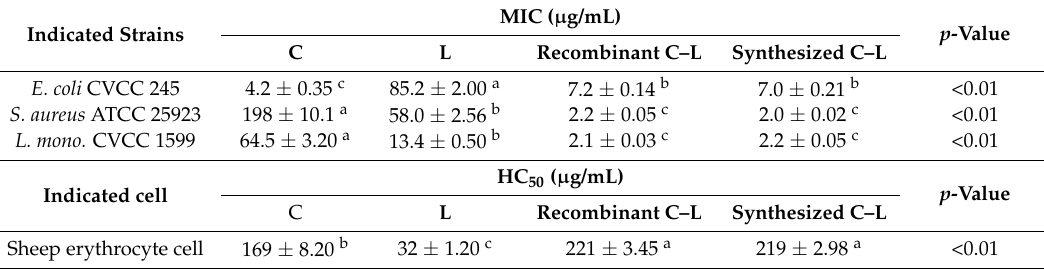
Table 1. The minimal inhibitory concentrations (MICs) and hemolytic activity (HC 50 ) of C, L, recombinant C–L, and synthesized